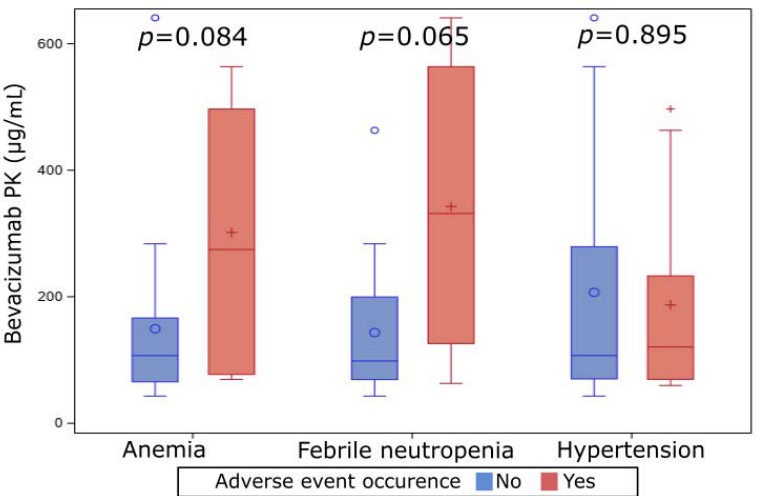
Figure 5. Correlation of post C1/C2 bevacizumab pharmacokinetics data to treatment-related adverse events for patients enrolled in the experimental arm of the AVASTEM